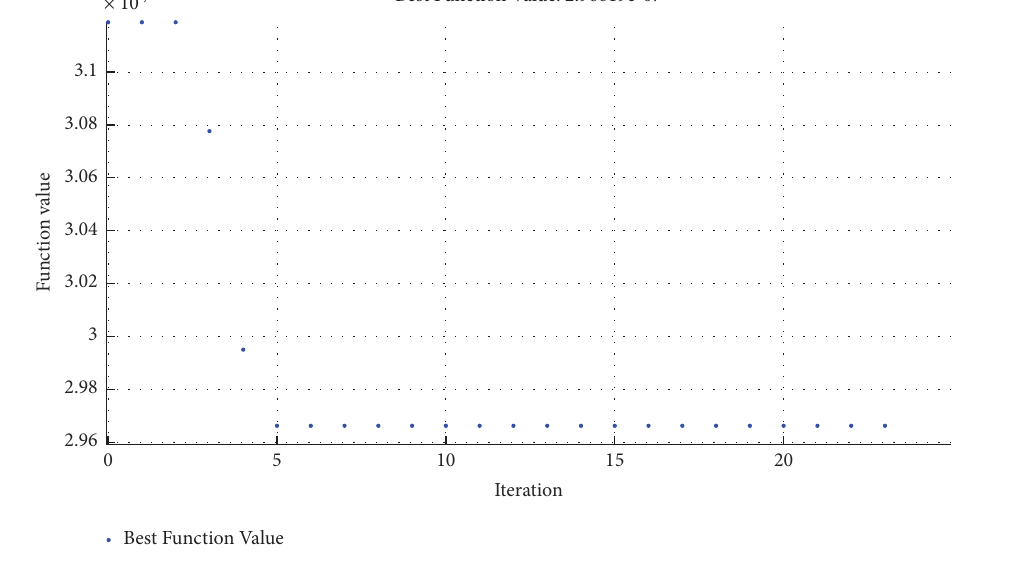
Figure 7: Fitness value of the PSO algorithm.